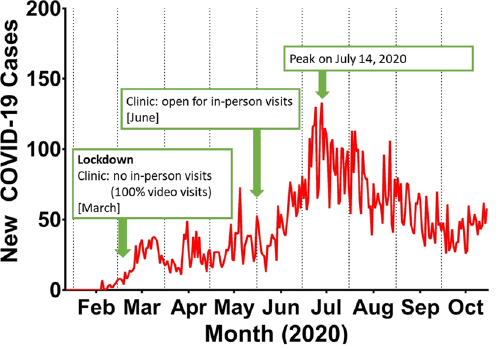
Figure 1. New COVID-19 cases in San Mateo county where the Stanford Pain Management. Center is located. Data were obtained from https:// www. smche alth. org/ coron avirus- health-